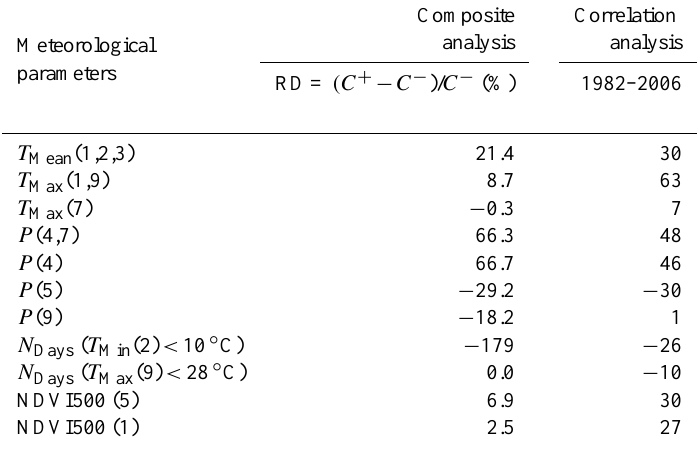
–, Mallows’ CP, Durbin Adj